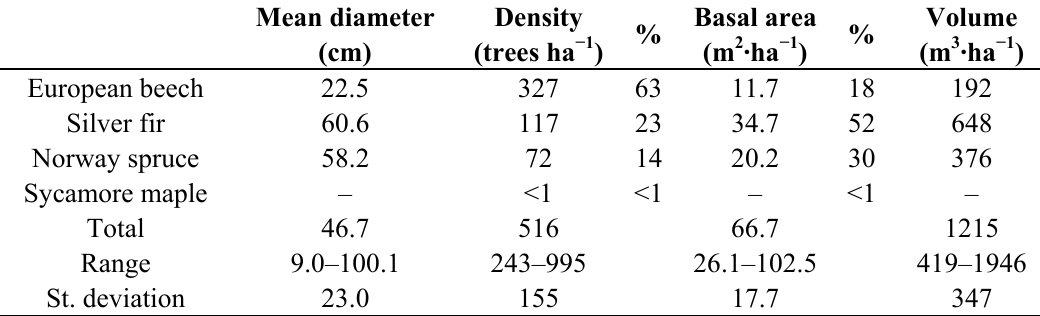
Table 1. Structural characteristics of the Janj old-growth forest (core